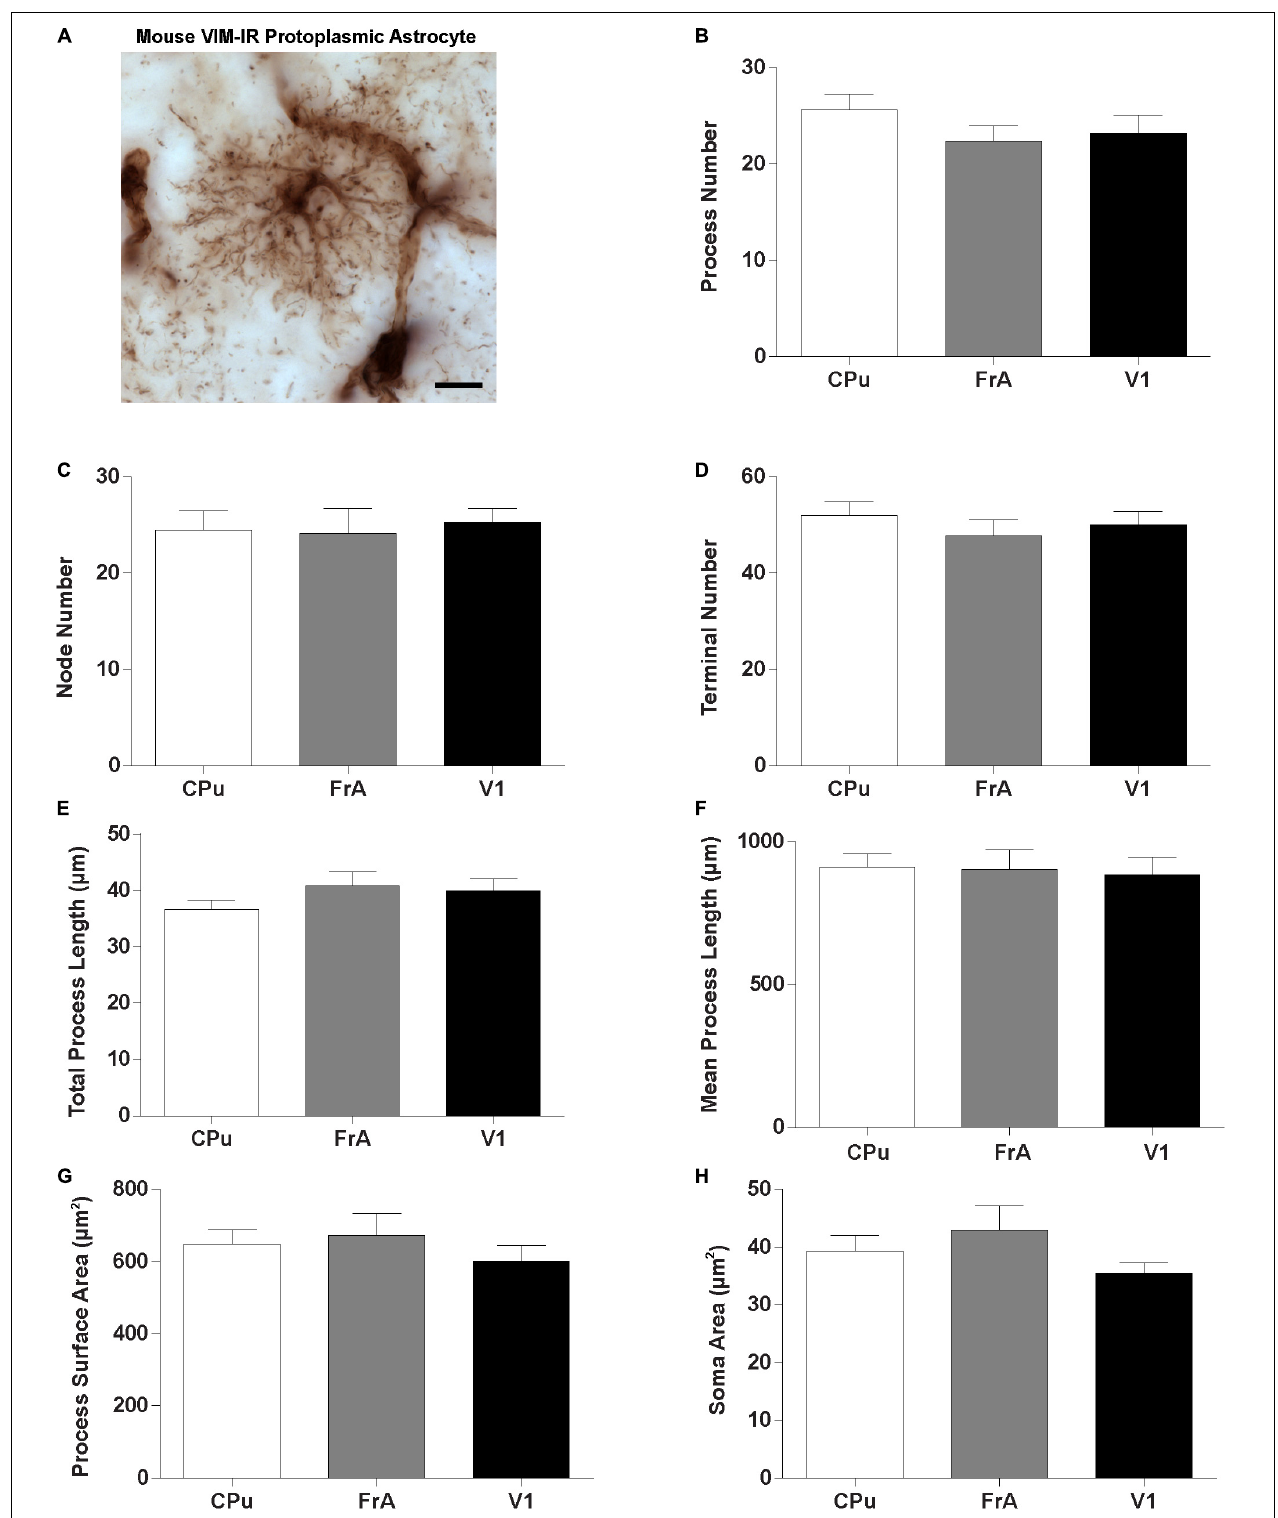
FIGURE 7 | Lack of regional heterogeneity in mouse VIM-IR astrocyte morphometry. (A) Representative VIM-IR astrocyte from the mouse frontal association cortex gray matter. (B–H) In the mouse brain, comparing VIM-IR astrocytes between regions revealed no significant difference ( p > 0.05) for any of the BSA. Scale bars = 10 µ m ( n = 5; Friedman